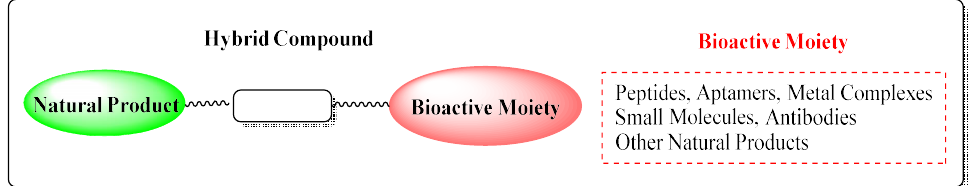
Figure 1. General structure of a natural product-based hybrid.